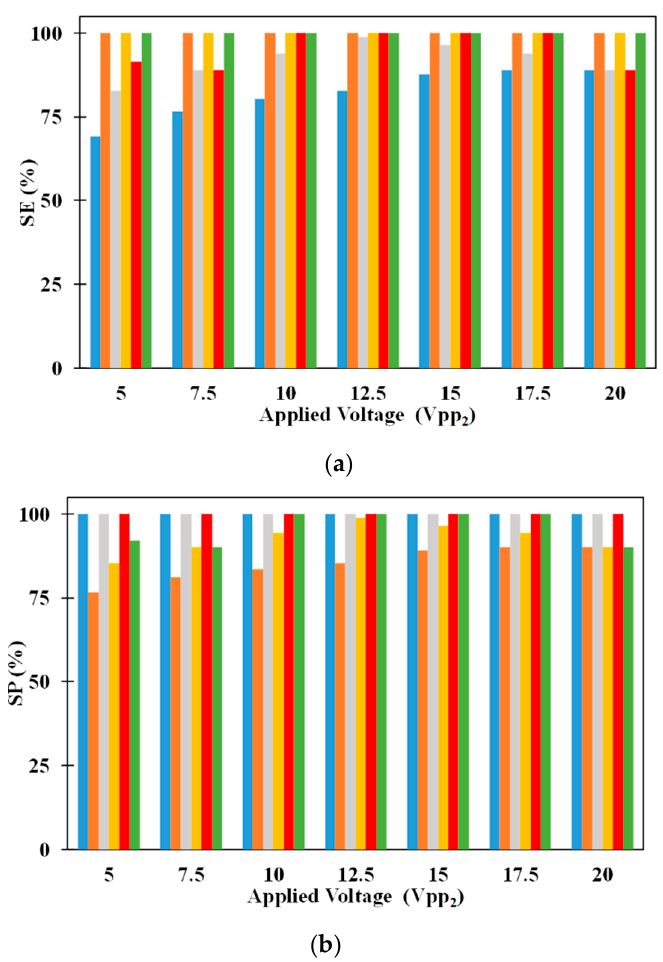
Figure 7. Influence of number of electrodes on ( a ) SE and ( b ) SP for n = 10 ( ■ : 2.5 μ m, ■ 5 μ m), n = 20 ( ■ : 2.5 μ m, ■ 5 μ m), and n = 30 ( ■ : 2.5 μ m, ■ 5 μ m); Q m = 200 μ L/h, W ch = 100 μ m, H ch = 100 μ m, V pp1 = 20 V pp , N = N cr,5 = 192.8